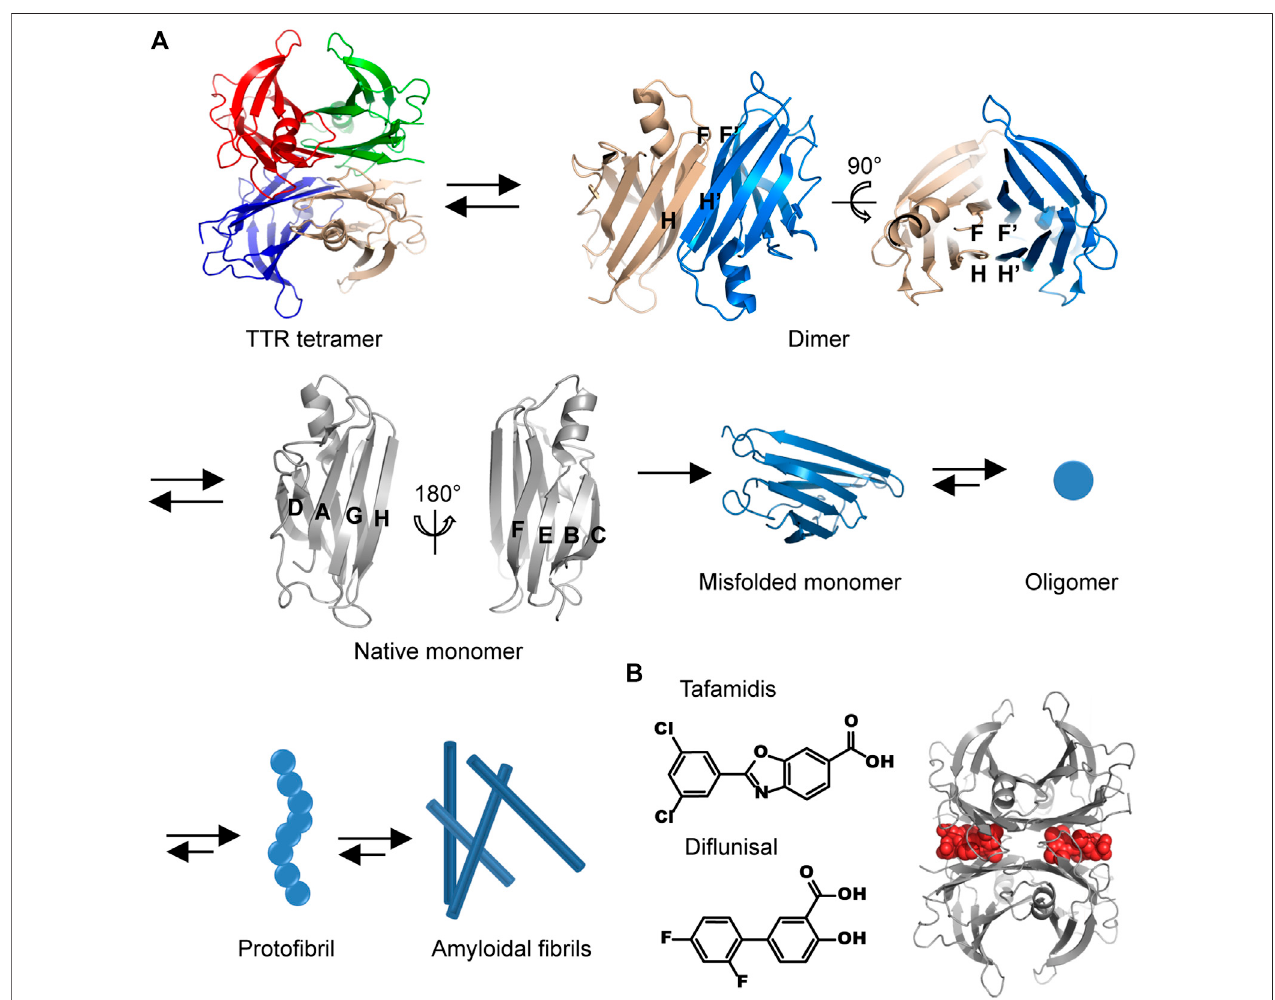
FIGURE 1 | The molecular pathway of TTR amyloidal aggregation. (A) The structural illustration of the dissociation of TTR tetramer into monomer and the aggregation of TTR misfolded monomer. Different protein chains are indicated by different colors. The structures of TTR tetramer, dimer, and monomer are drawn by using the crystallographic data of PDB ID 1F41. (B) The chemical structures of tafamidis and di fl unisal (left) and the representative model of structural stabilizers occupying the thyroxine binding site (right, the structure is drawn by using the crystallographic data of PDB ID 2ROX). Gray, a TTR tetramer; red, two binding structural